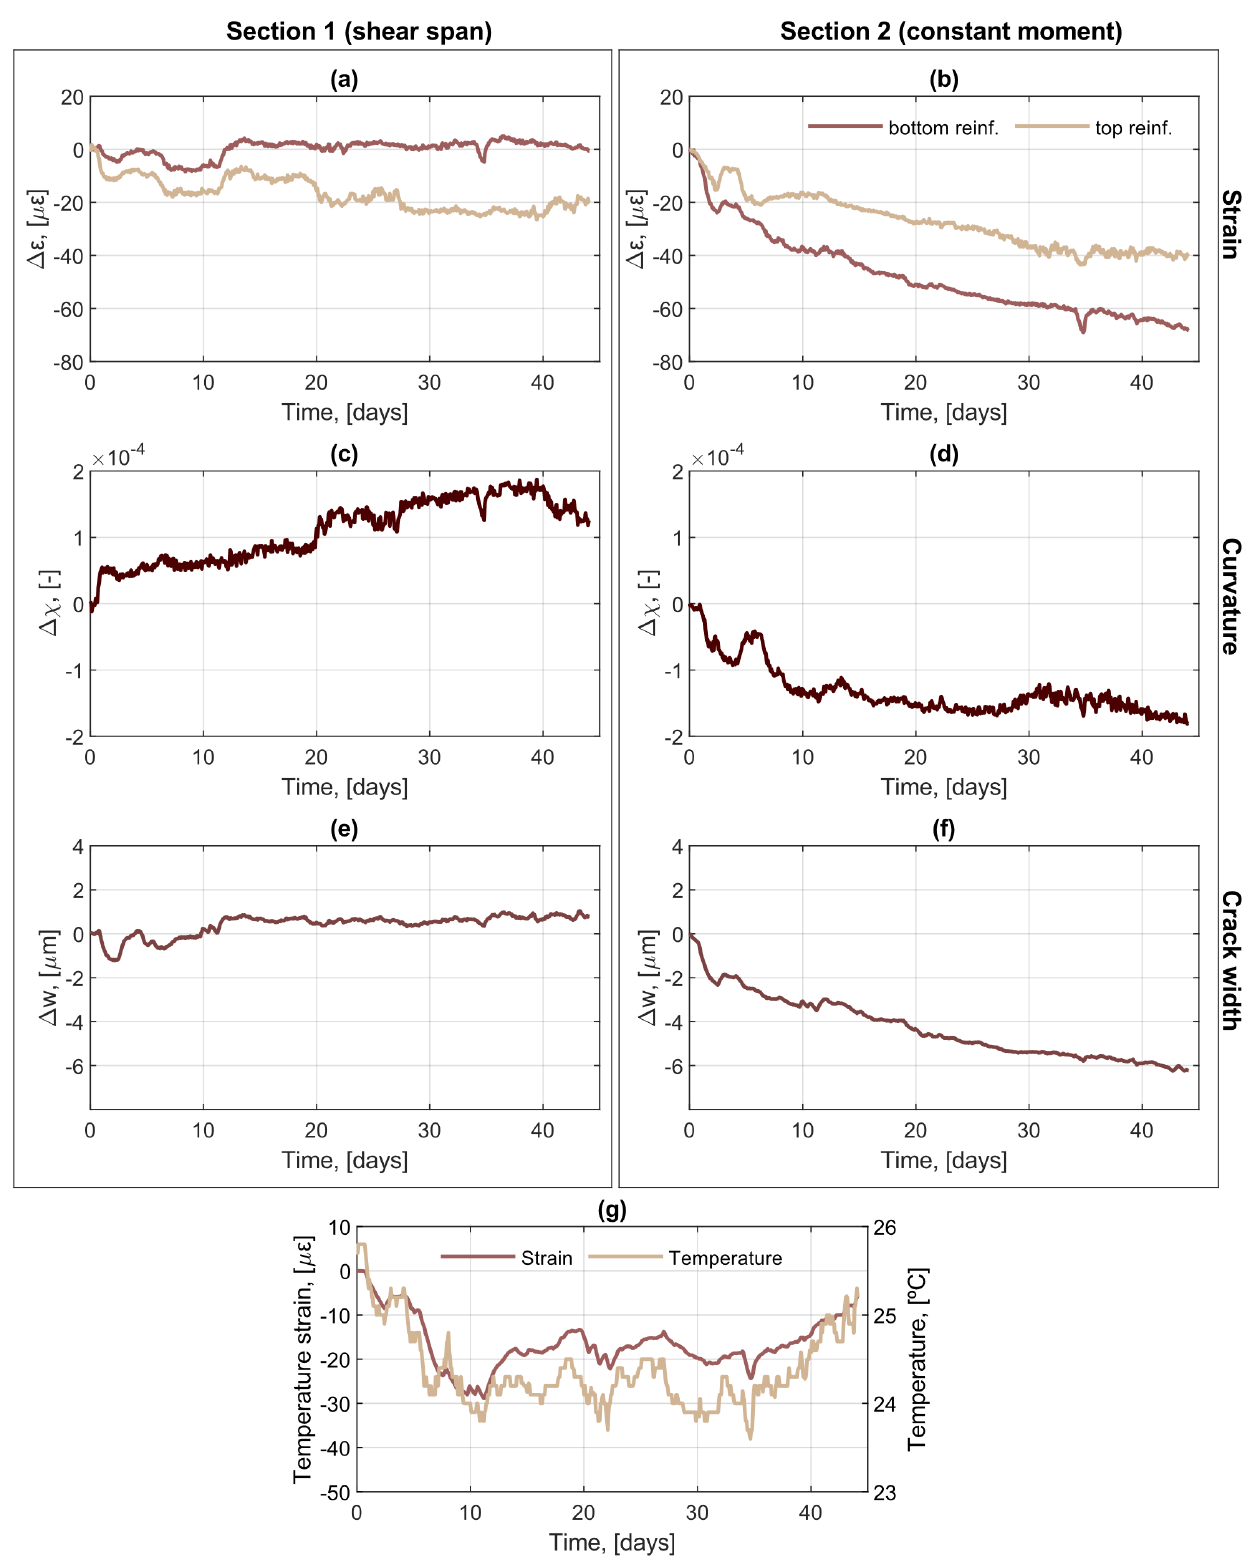
Figure 5. Incremental variation of measured and calculated magnitudes in the beam over time for Section 1 and Section 2: ( a , b ) strain; ( c , d ) curvature; ( e , f ) crack width. ( g ) Variation of ambient temperature and the corresponding temperature- induced strain.